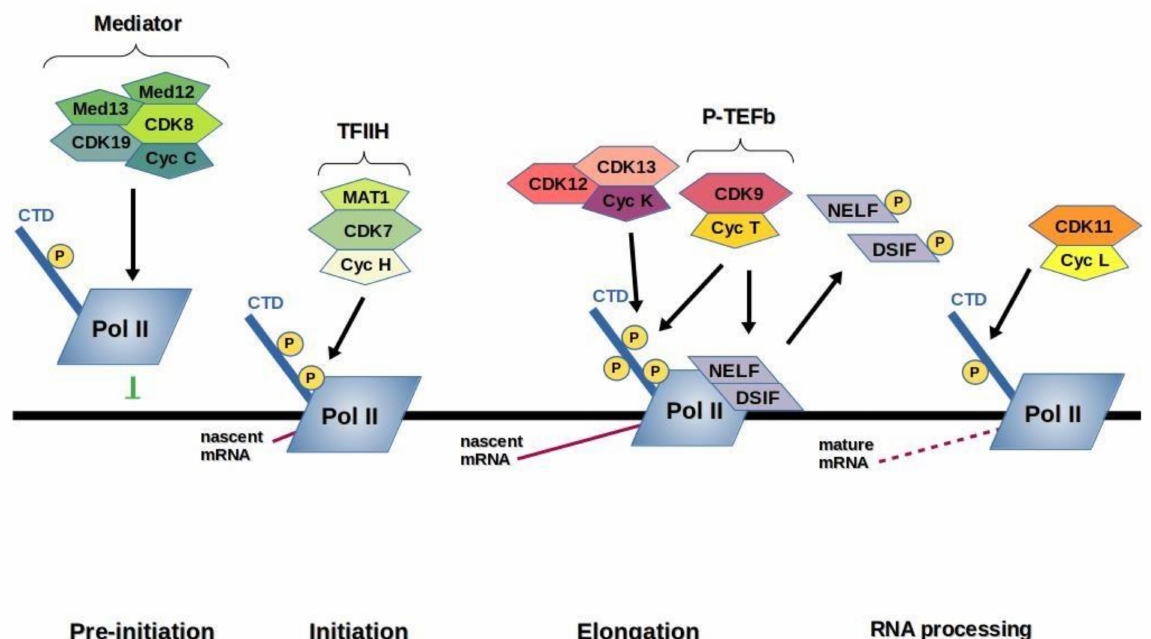
Figure 2. Regulation of transcription initiation and elongation by CDKs. The Mediator phosphorylates RNAP-II. CDK7/cyclin H phosphorylate RNAP-II CTD at Ser 5, which allows promoter clearance by RNAP-II. Phosphorylation of CTD at Ser 2 by CDK9, CDK12, and CDK13 originates in transcriptional elongation. CDK11 regulates the transcriptional activity and the mRNA